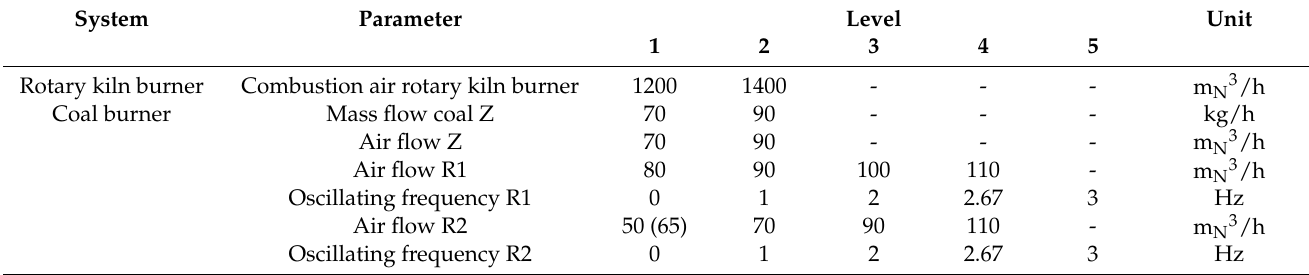
Table 1. Varied parameters and their levels in campaign A.